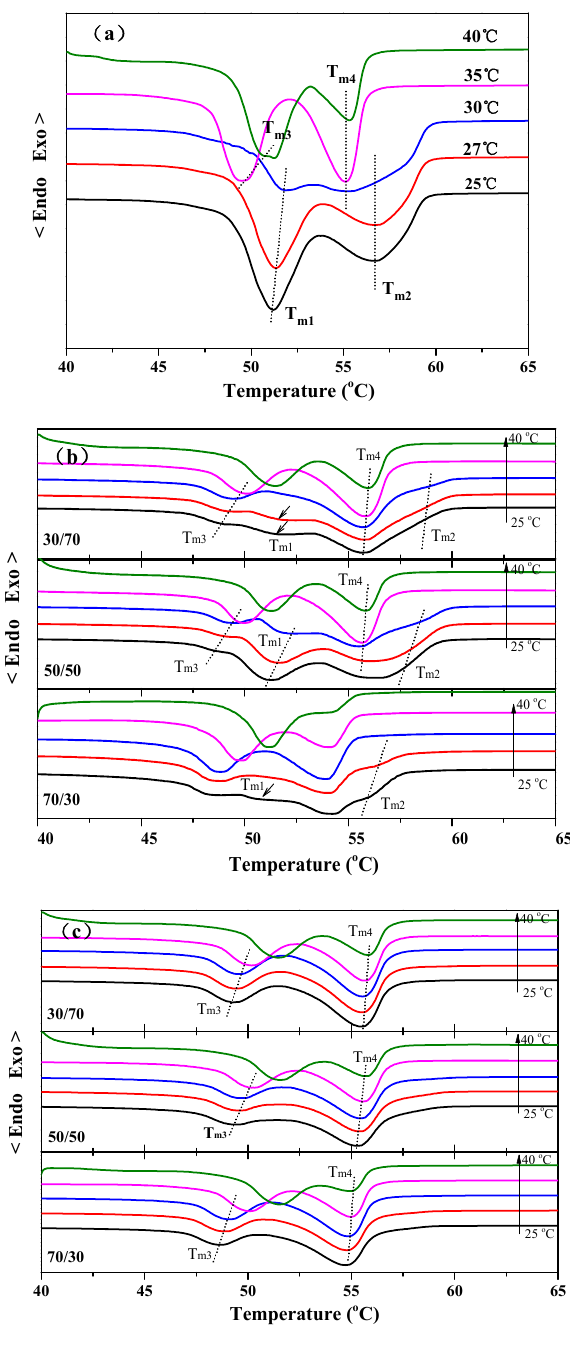
Figure 2. DSC melting curves of ( a ) neat PBA, ( b ) PBA in PBS/PBA blend, and ( c ) PBA in sheared blend after being melt-crystallized at various temperatures.